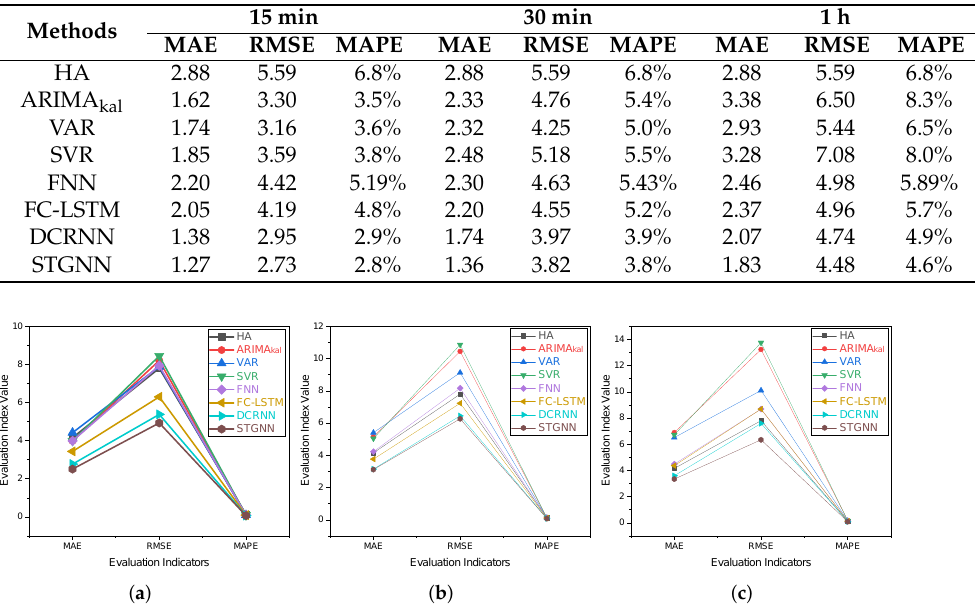
Figure 6. Performance comparison of models over different time periods on the METR-LA datasets. ( a ) Performance comparison of models in 15 min time period. ( b ) Performance comparison of models in 30 min time period. ( c ) Performance comparison of models in 60 min time period.